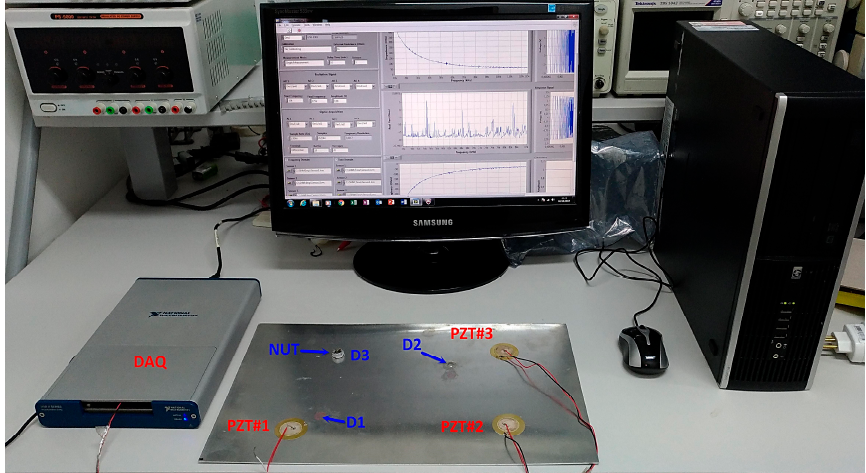
Figure 4. Experimental set up including: aluminum plate containing three PZT patches, DAQ (Data Acquisition) and computer running the acquisition software